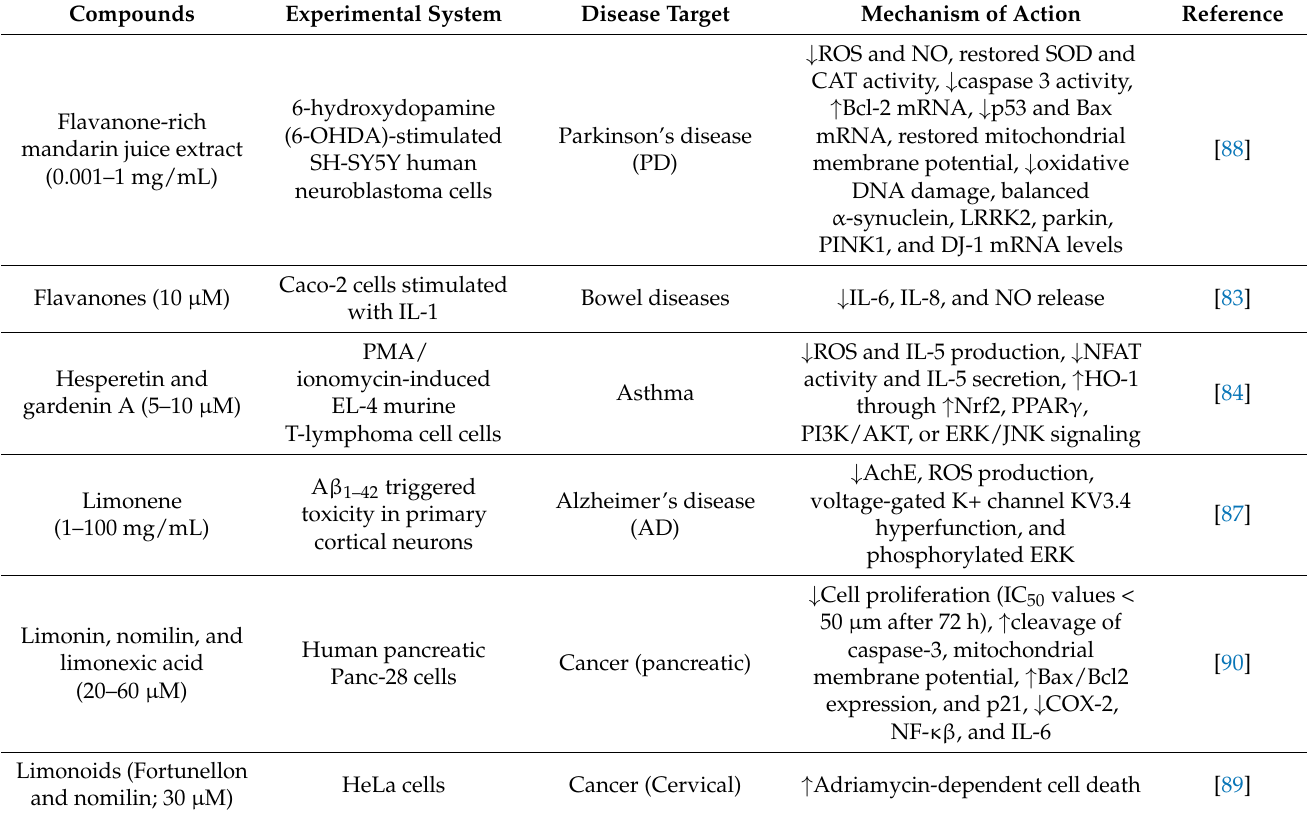
Table 3. Health benefits of citrus fruit bioactive compounds demonstrated using in vitro experimen- tal